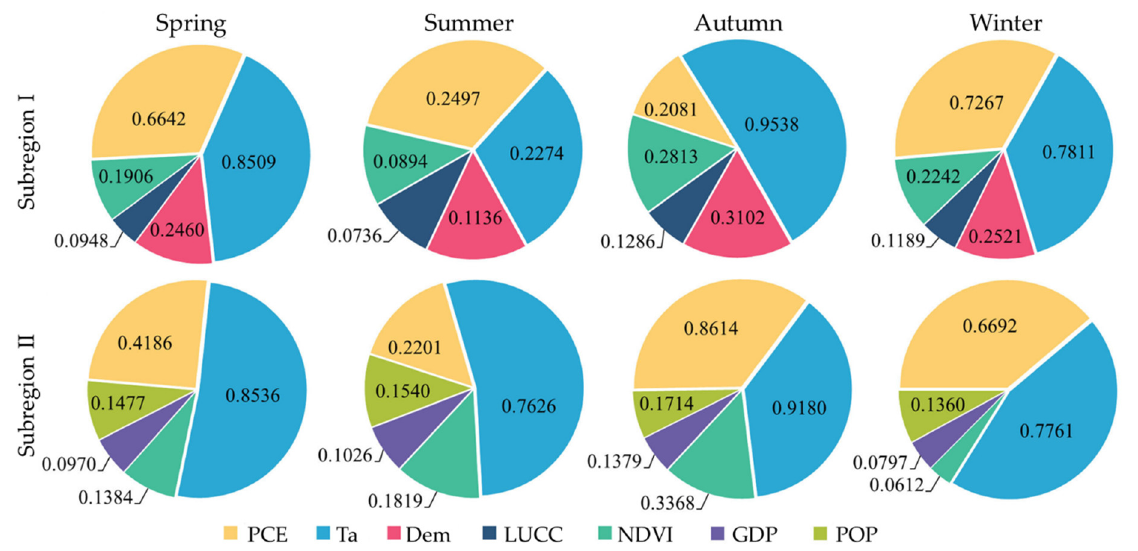
Figure 4. Statistics of q values of single factors influencing the soil moisture in spring, summer, autumn, and